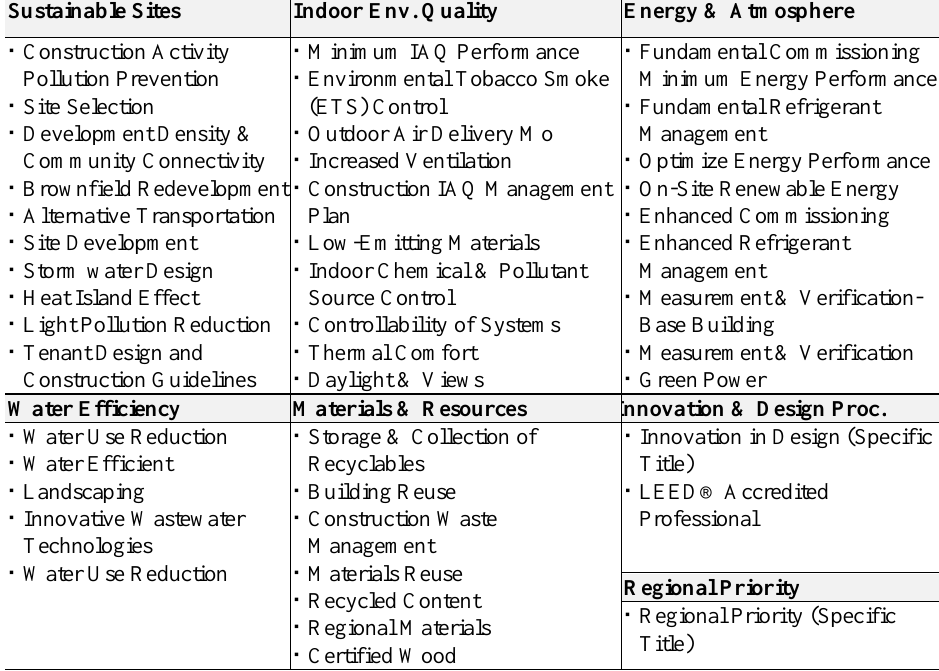
Table 3 – LEED criteria for New Construction Rating System Sustainable Sites Indoor Env. Quality Energy &